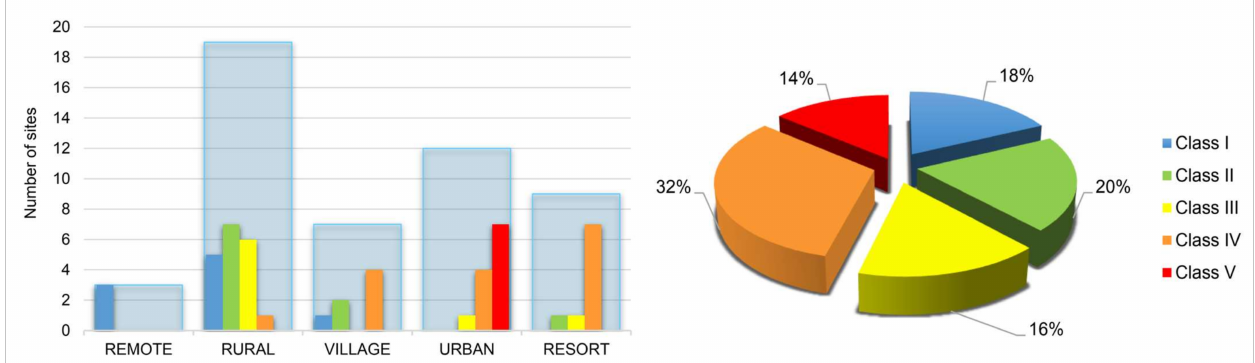
Figure 3. D scenic values for 50 sites along the Moroccan Mediterranean coast.